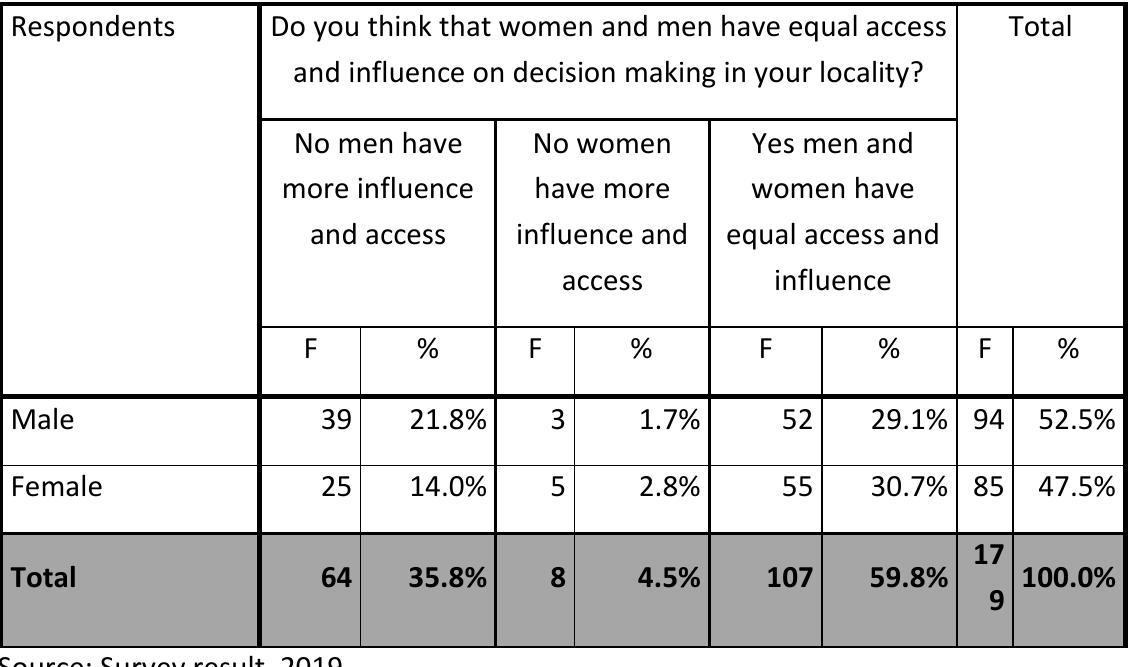
Table 12: Men and Women access to and influence on decision making in the town